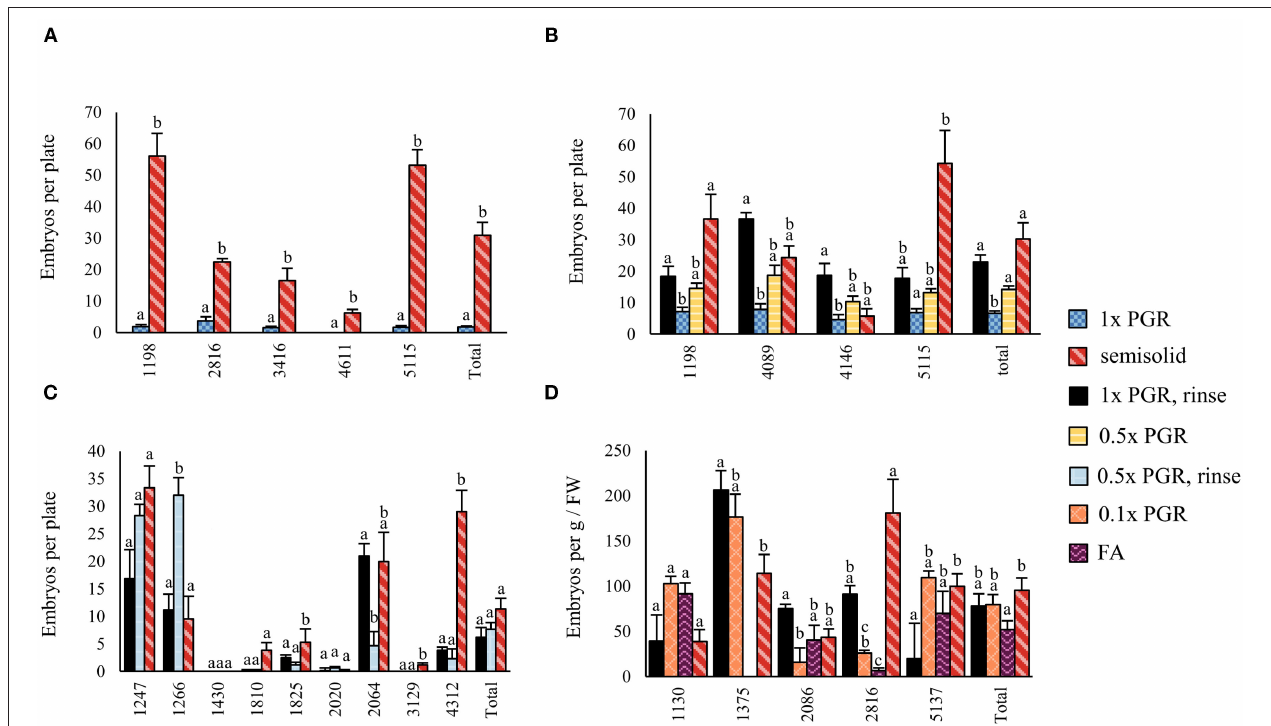
FIGURE 3 | Embryo production in Experiments I (A) , II (B) , III (C) , and IV (D) . 1x PGR, 0.5x PGR, and 0.1x PGR stand for the concentrations of plant growth regulators 2,4-D and BA in suspension cultures. In Experiments I–III, embryos per plate were counted, and in Experiment IV, it was standardized per g of ET put to maturation plates. Mean values are presented with the SEM. Significant differences between treatments within lines or overall (Total) are marked with different